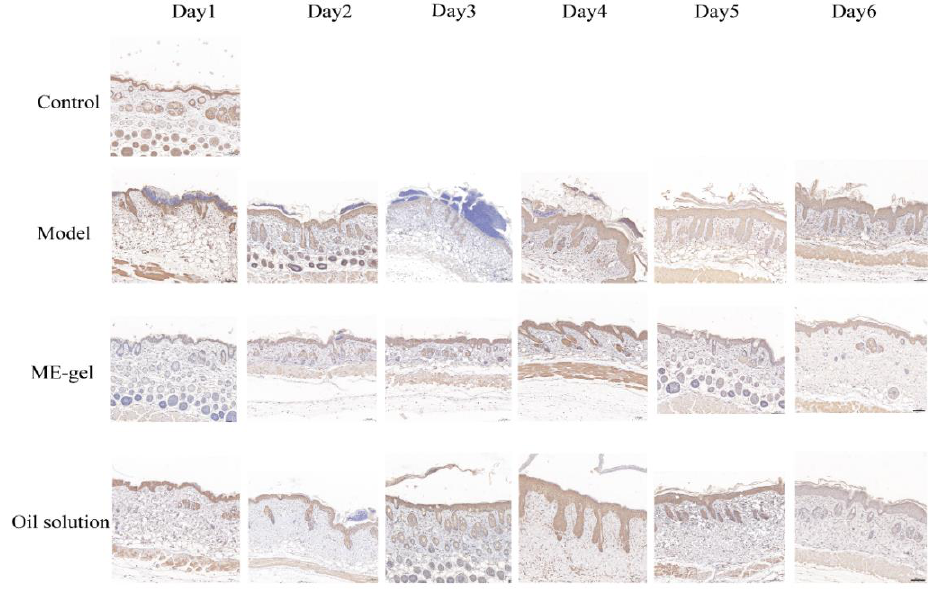
Figure 11. Effects of IR on the expression of CD4 + T on the back skin of psoriatic mice (magnification 100×; scale bar 100 µm).